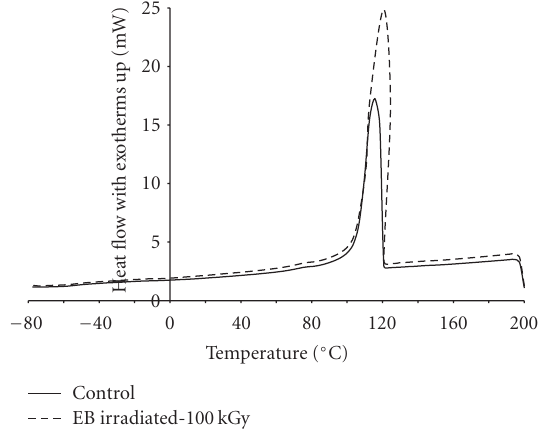
Figure 4: Crystallization exotherms of nanocomposites at 4vol% clay loading for control and EB-irradiated